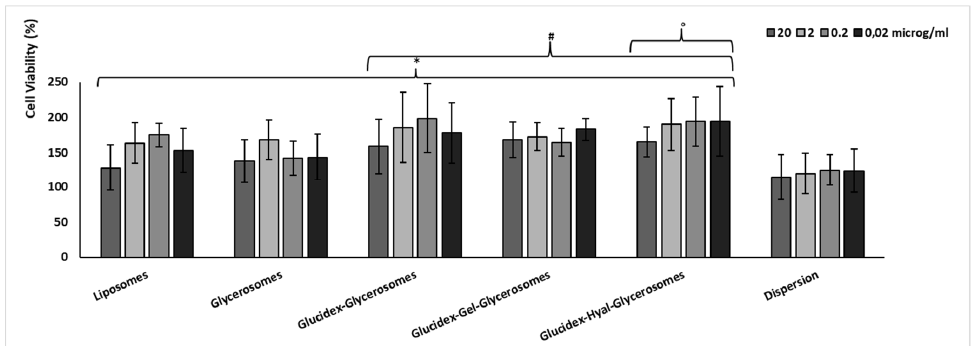
Figure 5. Viability of keratinocytes incubated for 48 h with different concentrations of H. scruglii extract in dispersion or loaded in vesicles. Data are reported as mean values ± standard deviations of cell viability expressed as the percentage of control (untreated cells; 100% of viability). The symbol (*) indicates values statistically different from dispersion (p < 0.05); (#) indicates values statistically different from glycerosomes (p < 0.05); (°) indicates values statistically different from liposomes (p < 0.05).